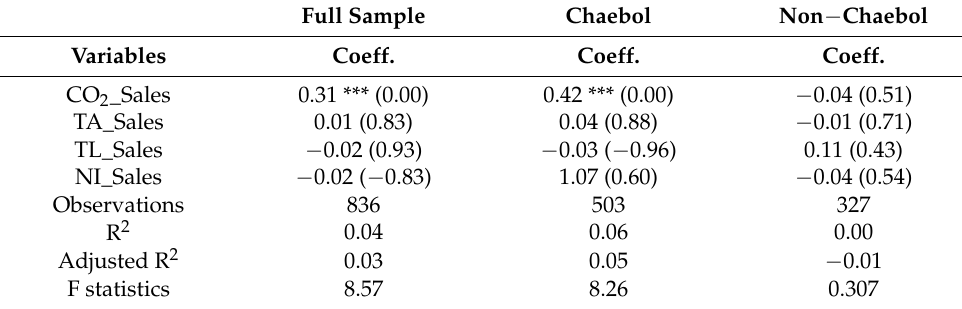
Table 6. Results for carbon emission and firm value